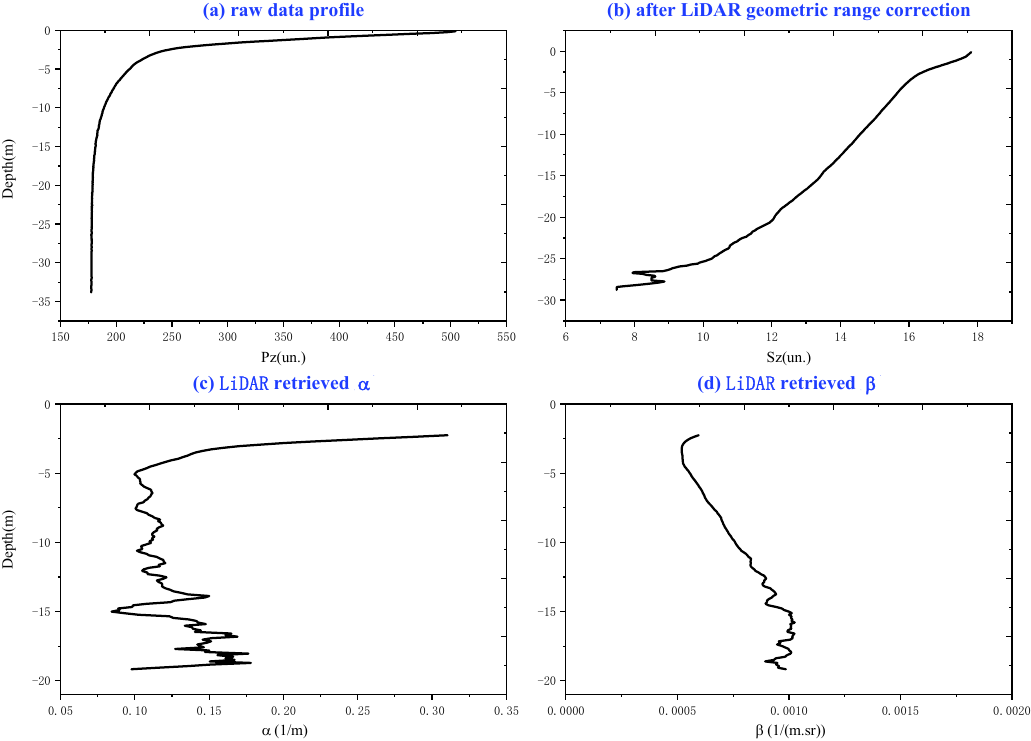
Figure 4. An example of processing the LiDAR data acquired on 30 September, 2017. ( a ) The profile from the raw LiDAR data, ( b ) the geometric range corrected LiDAR return in logarithmical form after background-noise subtraction, ( c ) the profile from the retrieved α , and ( d ) the profile from the retrieved β .